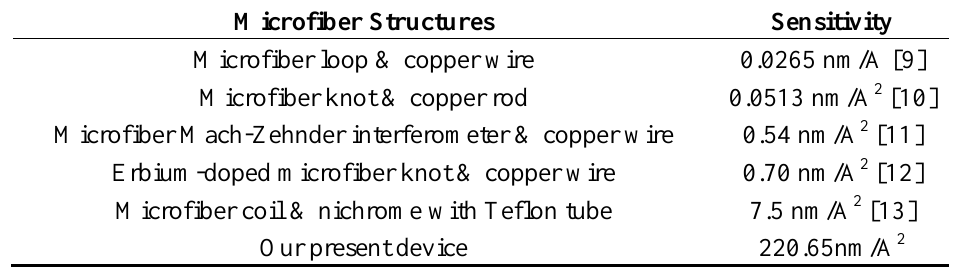
Table 1. Electric-current sensitivities utilizing the thermal effect for the metal-microfiber